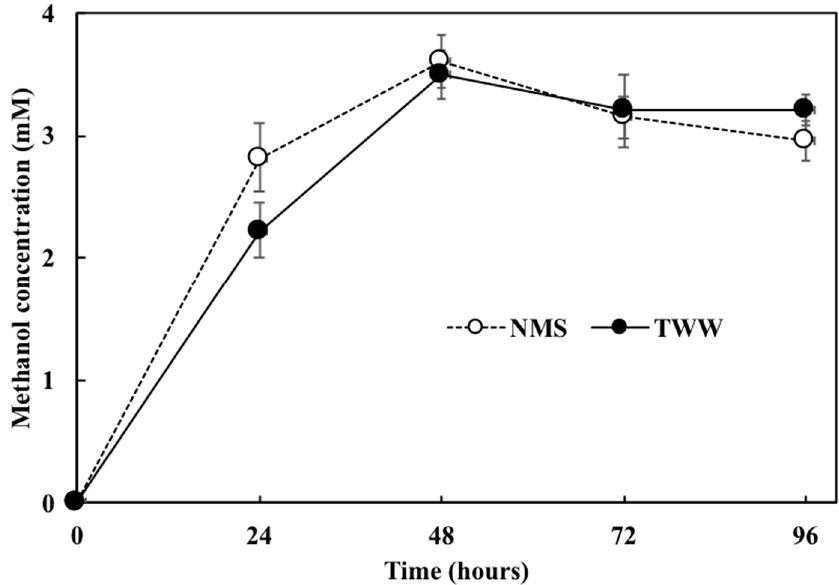
Figure 4. Changes in methanol production in NMS medium and TWW supplemented with nitrate and phosphate.